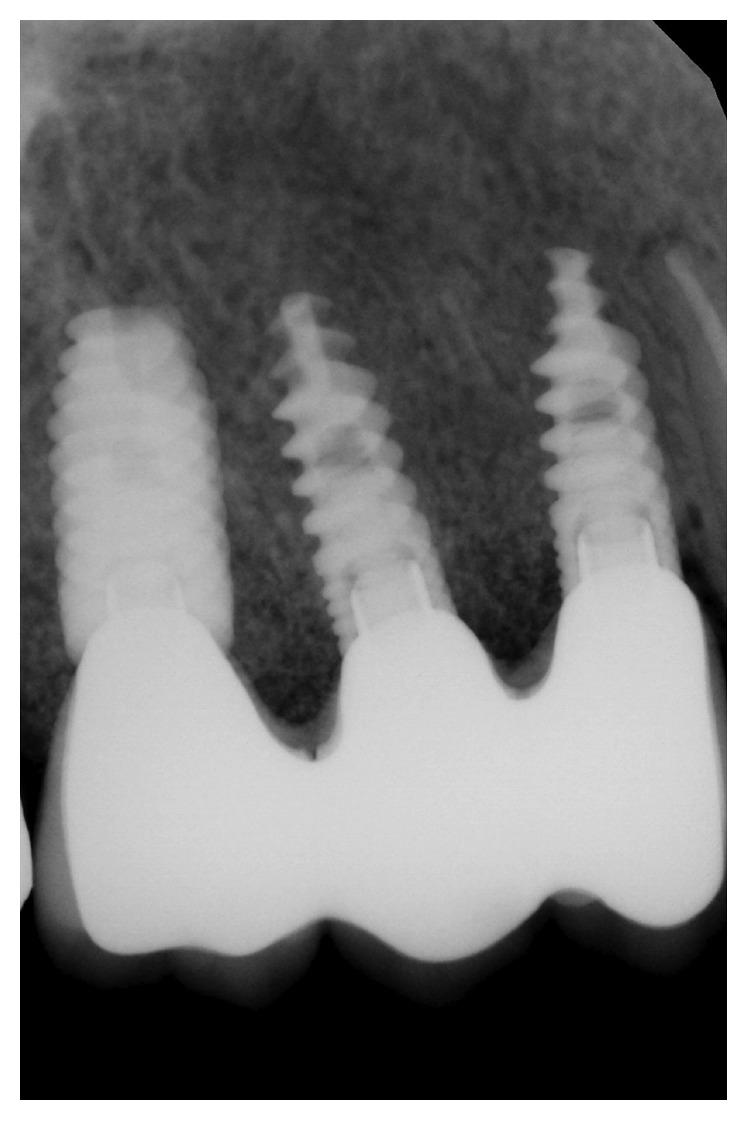
One-year follow-up.